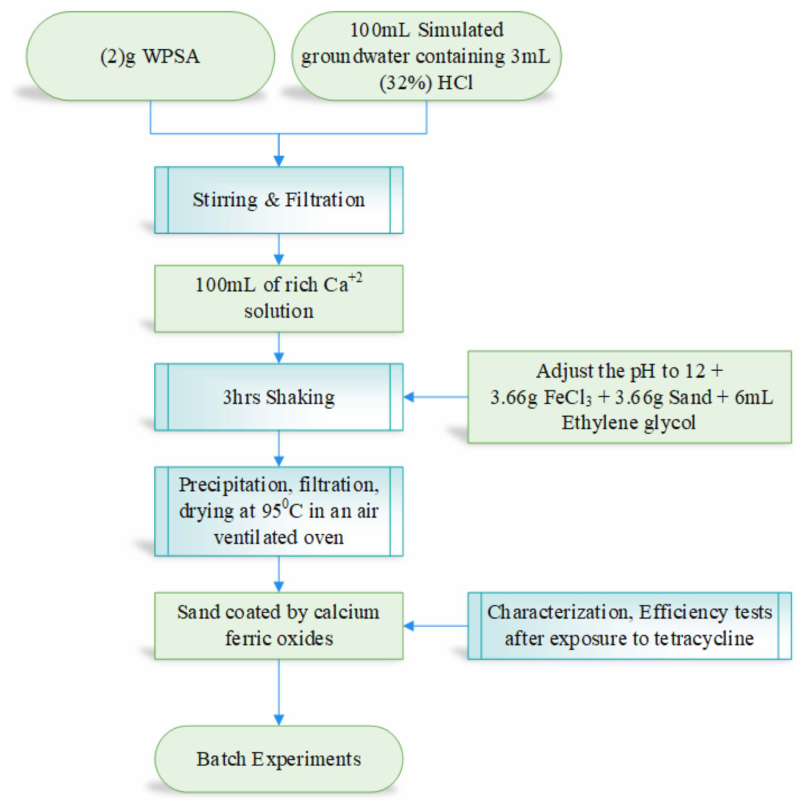
Figure 4. Block diagram for the synthesis of calcium ferric